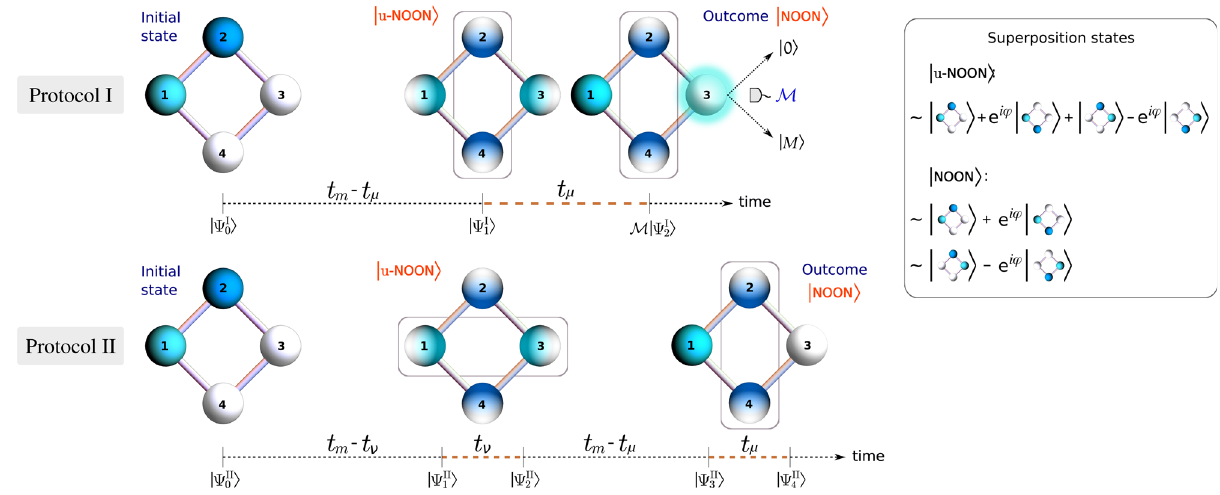
Fig. 1 NOON state generation scheme. The four spheres on the left represent the initial state, with white indicating an empty site. Cyan and blue correspond to M and P particles, respectively. In time-evolved states, gradient colors are used to indicate that the state of a site is entangled with the rest of the system - superposition states for each step are shown in the framed legend. The bars connecting the spheres denote tunneling between nearest- neighbor sites, while the rectangles represent applied external fi elds to sites 1 – 3 ( ν ) and 2 – 4 ( μ ). In Protocol I, the system initially evolves for time t m − t μ , towards the u-NOON state. Then, a fi eld is applied across sites 2 – 4 for time t μ (dashed brown time line), to encode a phase. Finally, the light cyan halo portrays a projective measurement process at site 3, denoted by M . The outcomes 0 j i and M j i signify which of two possible NOON states results across sites 2 – 4. Similarly in Protocol II, the system fi rst evolves for time t m − t ν , then a fi eld is applied to sites 1 – 3 for time t ν to implement the phase π /2. Next, the system evolves for time t m − t μ , after which a fi eld is applied to sites 2 – 4 to encode a phase during time t μ . This results in a NOON state across sites 2 – 4, without performing a measurement